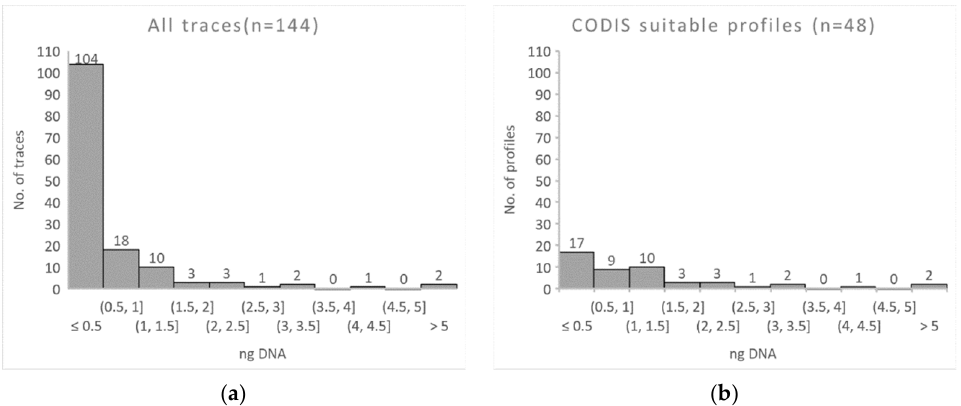
Figure 3. Histograms of the distributions of DNA amounts in ng obtained from: ( a ) all samples and ( b ) samples for which we were able to establish CODIS-suitable DNA profiles.